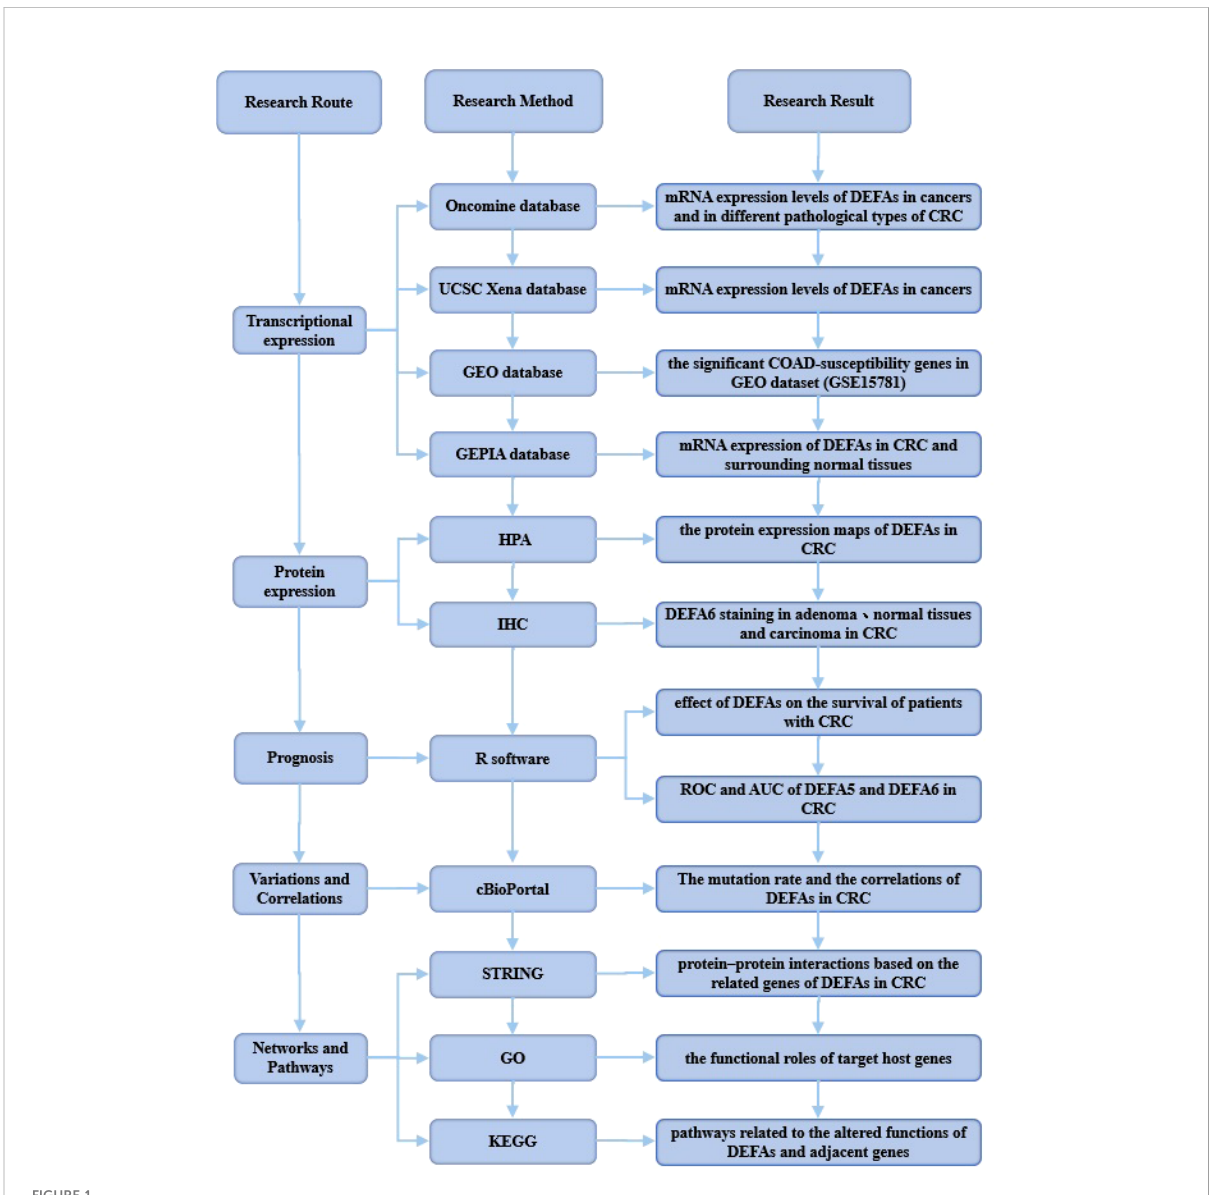
FIGURE 1 Flow diagram of the data collection and method implementation in this